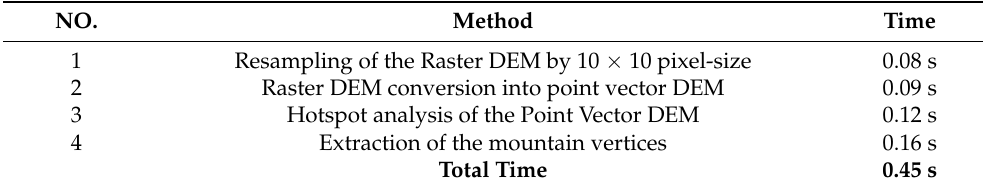
Table 17. The time consumed in extracting mountain vertices for the fifth dataset using our pro- posed approach.